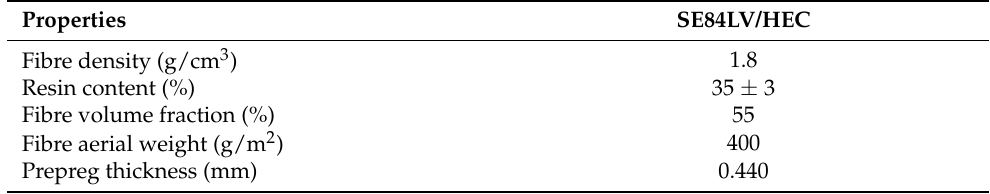
Table 1. Physicochemical properties of SE84LV/HEC carbon fibre/epoxy system [26].